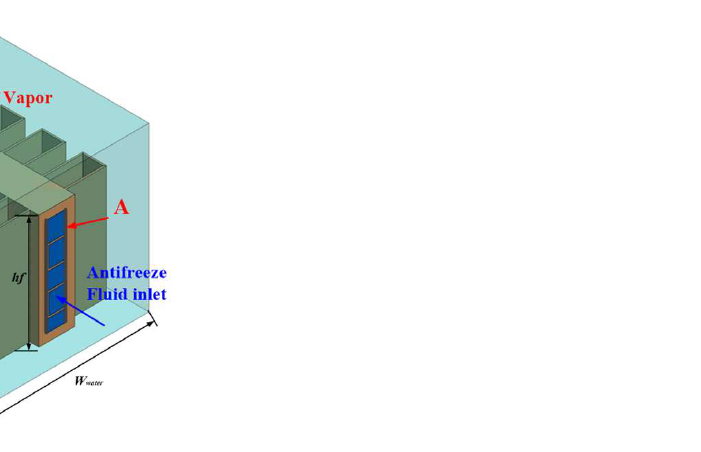
Figure 1. Structure of water evaporator and its channels (A and B represent internal channels and external fins, respectively). Table 1. Structure parameters of water evaporator.